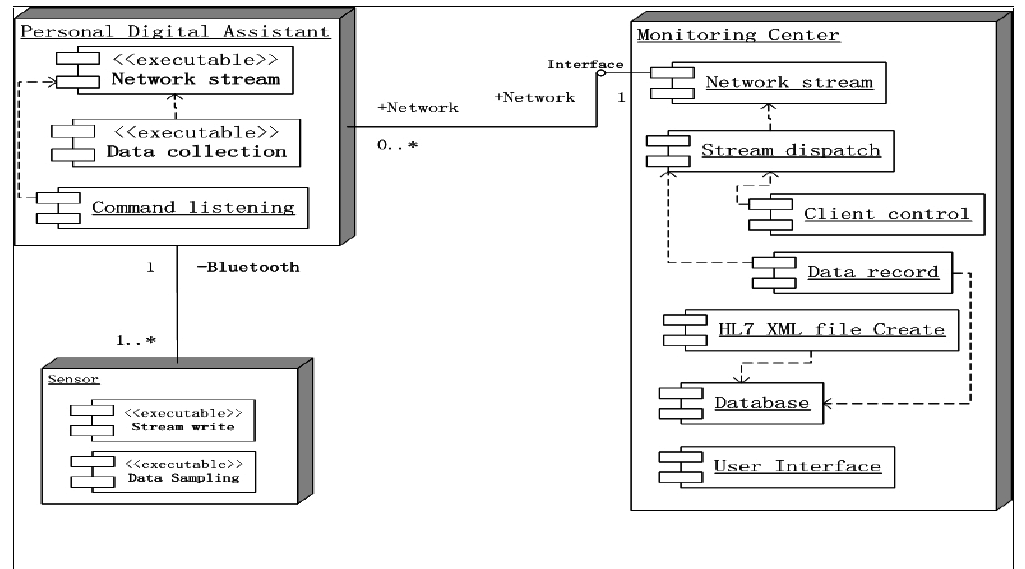
Figure 3. Healthcare monitoring system